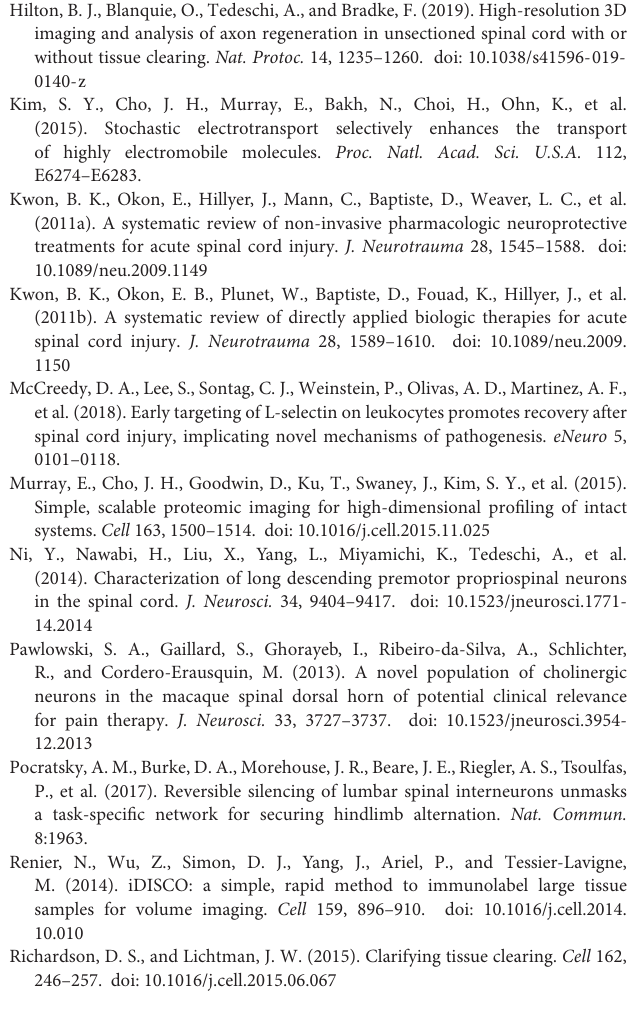
mouse. Supplementary Movie 3 | 3D lightsheet image of SWITCH-mediated DiD labeling in the intact spinal cord. Supplementary Movie 4 | 3D lightsheet image of SWITCH-mediated DiD labeling in the injured spinal cord at 42 days post-SCI. Supplementary Movie 5 | 3D lightsheet image of hTau (green) and NeuN (red) IF labeling in the intact spinal cord with transplanted hiPSC-derived V2a